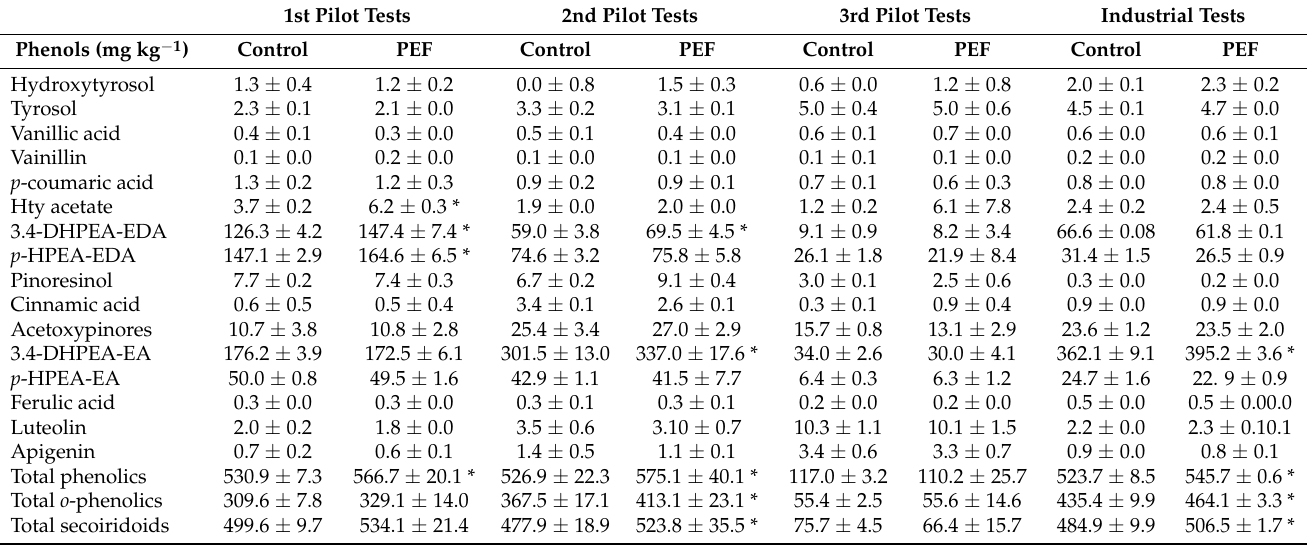
Table 5. Phenolic composition of control and PEF oils obtained from ‘Manzanilla’ and ‘Hojiblanca’